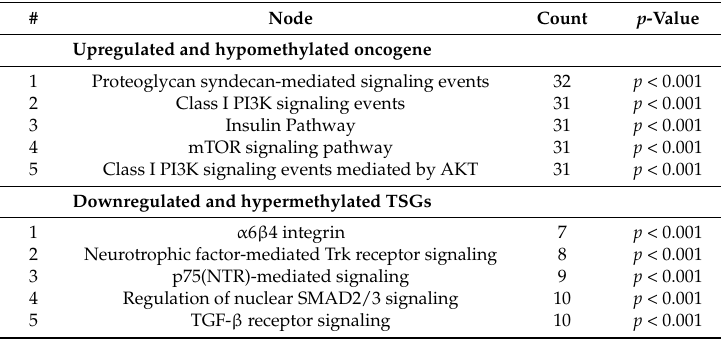
Table 1. The pathways in which the three oncogenes and the four tumor suppressor genes (TSGs) were mainly involved.